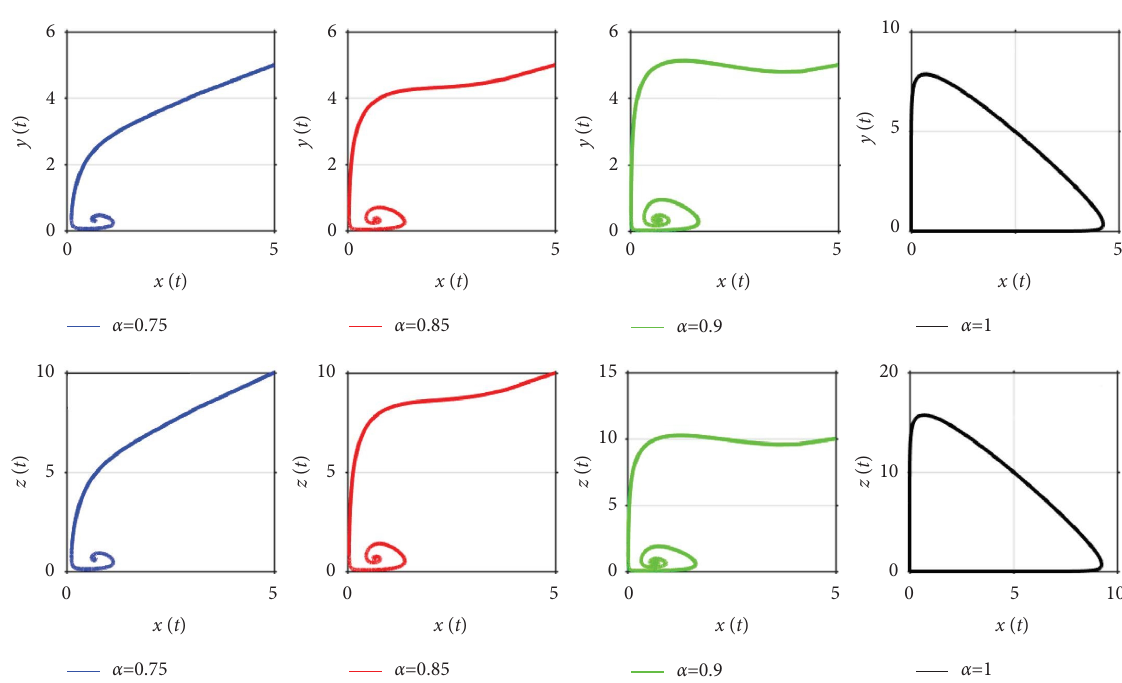
Figure 3: Phase space for the one prey-two predators system, where D ( x ) � 0 , G ( y ) � 0 , J ( z ) � 0 , a � b � c � 0 . 1 , e � h � 0 . 3 , f � i � 0 . 2 , and α � 0 . 75 , 0 . 85 , 0 . 9 , 1